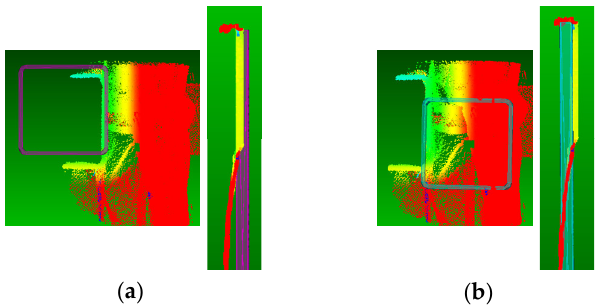
Figure 8. Results of heuristic model fitting of a hollow structural section (HSS) to contaminated point clouds using Verity: ( a ) original registered model and point cloud and ( b ) result of the incorrect model fitting.